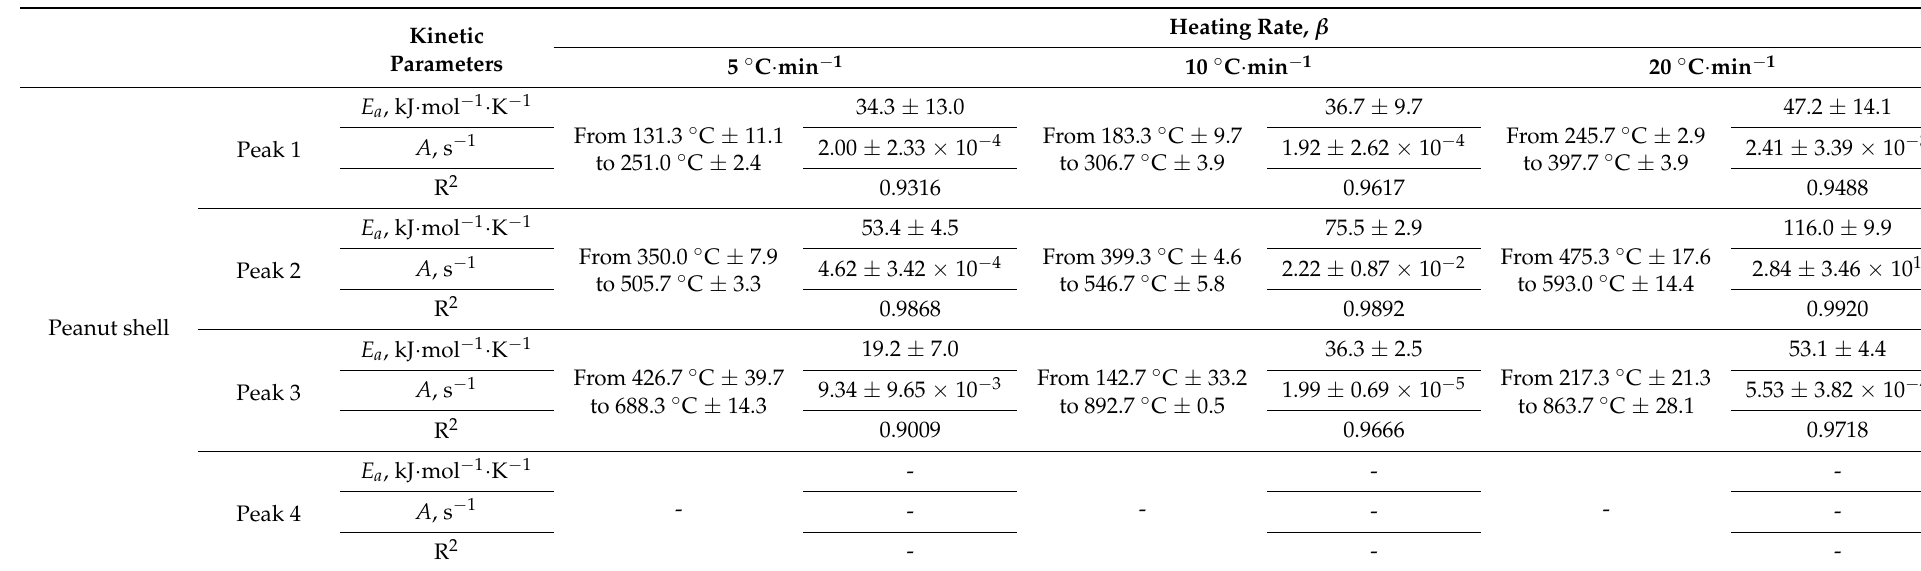
Table 7. Activation energy ( E a ) [kJ · (mol · K) − 1 ] and pre-exponential factor (A) [s − 1 ] for the PES fitted